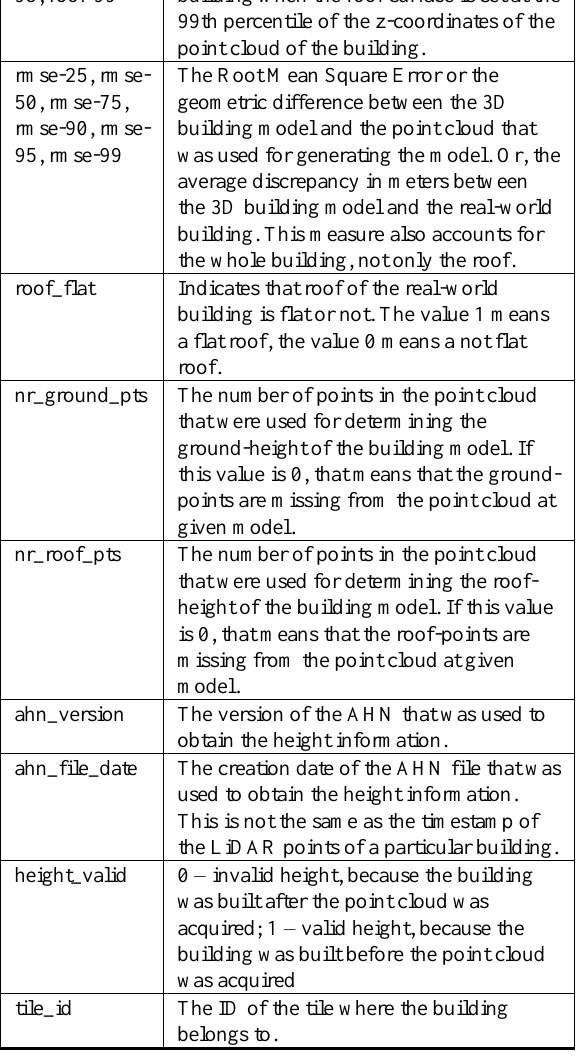
the attributes from the original building